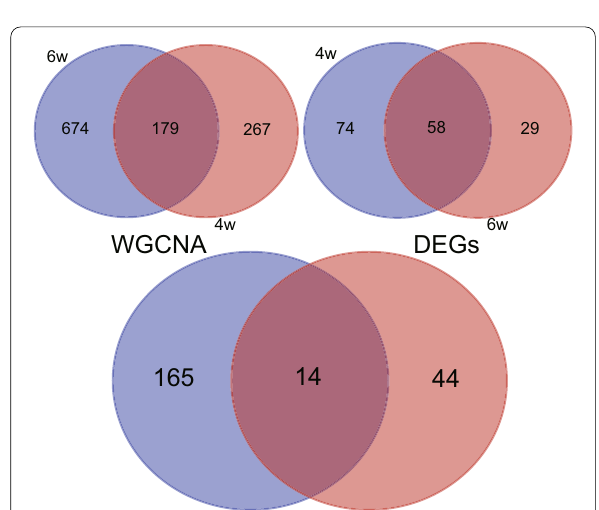
Fig. 3 Intersection analysis WGCNA and DEA for genes modulated by 4-week and 6-week doxorubicin treatment. Figure below represents the intersection analysis WGCNA and DEA